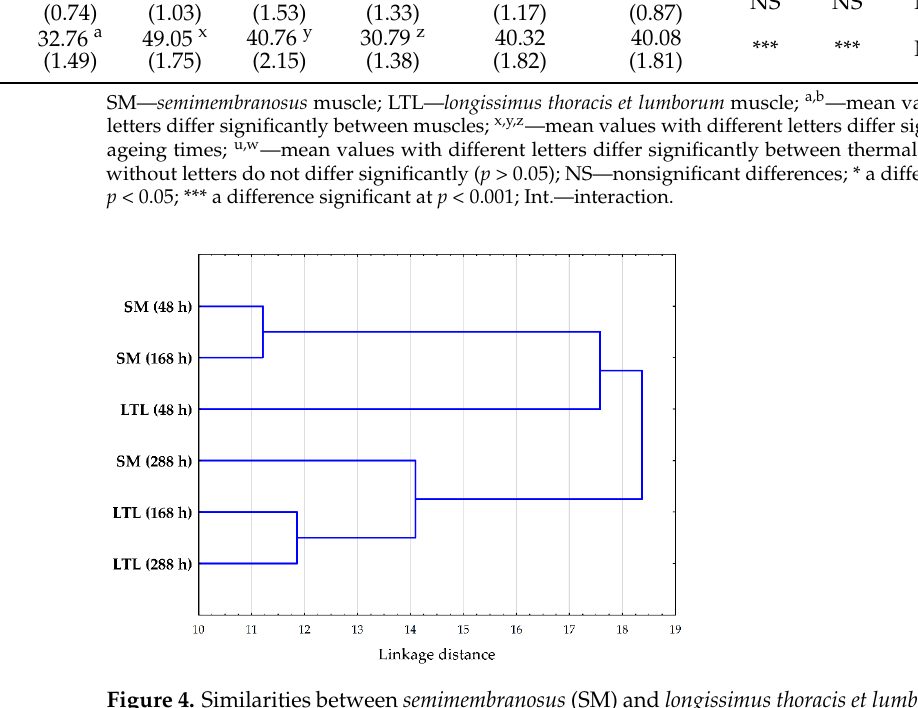
Figure 4. Similarities between semimembranosus (SM) and longissimus thoracis et lumborum (LTL) fallow deer muscles aged for a different time from 48 h to 288 h.